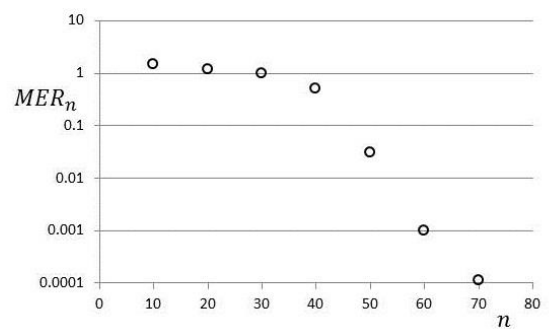
Figure 10. Logarithmic plot of the maximal error remainder parameters 𝑀𝐸𝑅 𝑛 .